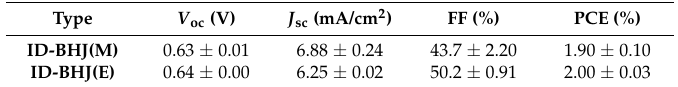
Figure 3. ( a ) The current density–voltage ( J – V ) curves for the devices; ( b ) external quantum efficiency (EQE) spectra of the ID-BHJ devices. M, DCM; E, DCE. Table 2. Photovoltaic parameters of organic photovoltaics (OPVs) with ID-BHJs prepared using different solvents for PC 71 BM.